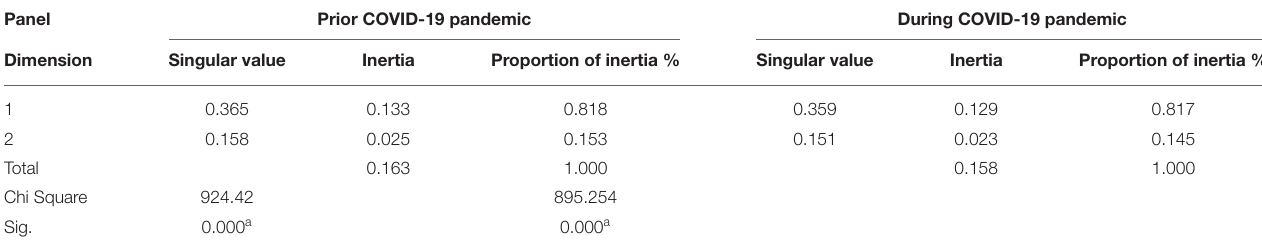
TABLE 3 | Statistics on correspondence analysis related to product type